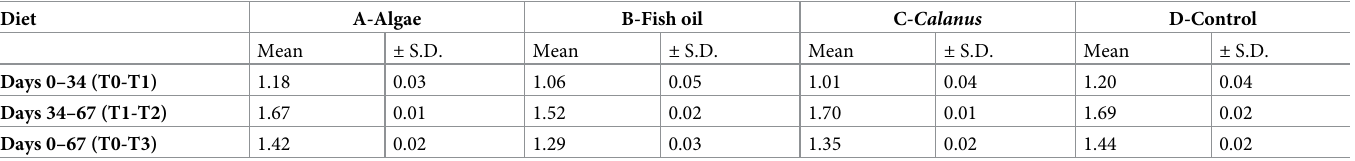
Table 2. Specific salmon growth rate (% day -1 ) during the experimental periods. Diet